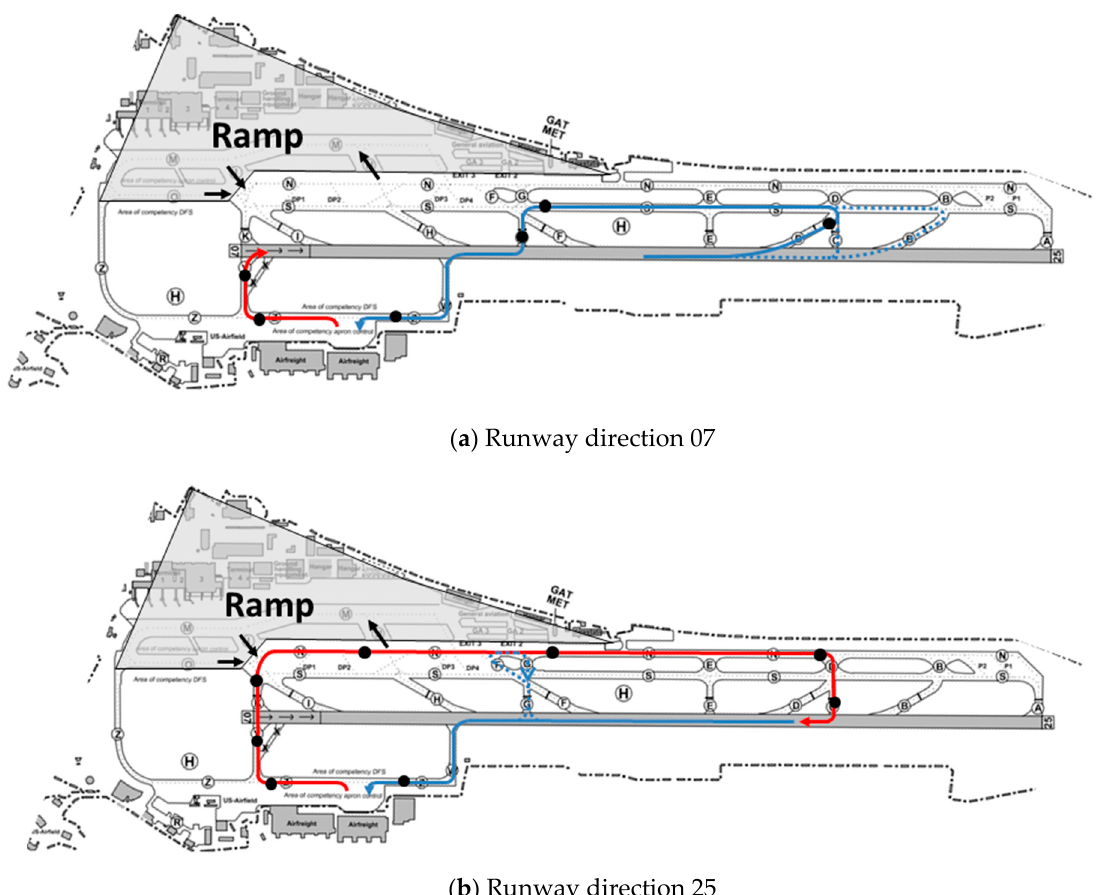
Figure 6. Predefined taxi routings at Stuttgart Airport allocated to RPA in case runway direction ( a ) 07 or ( b ) 25 is in use (Reference [9]). Aerodrome map provided by courtesy of DFS Deutsche Flugsicherung GmbH—not suited for navigational purposes.